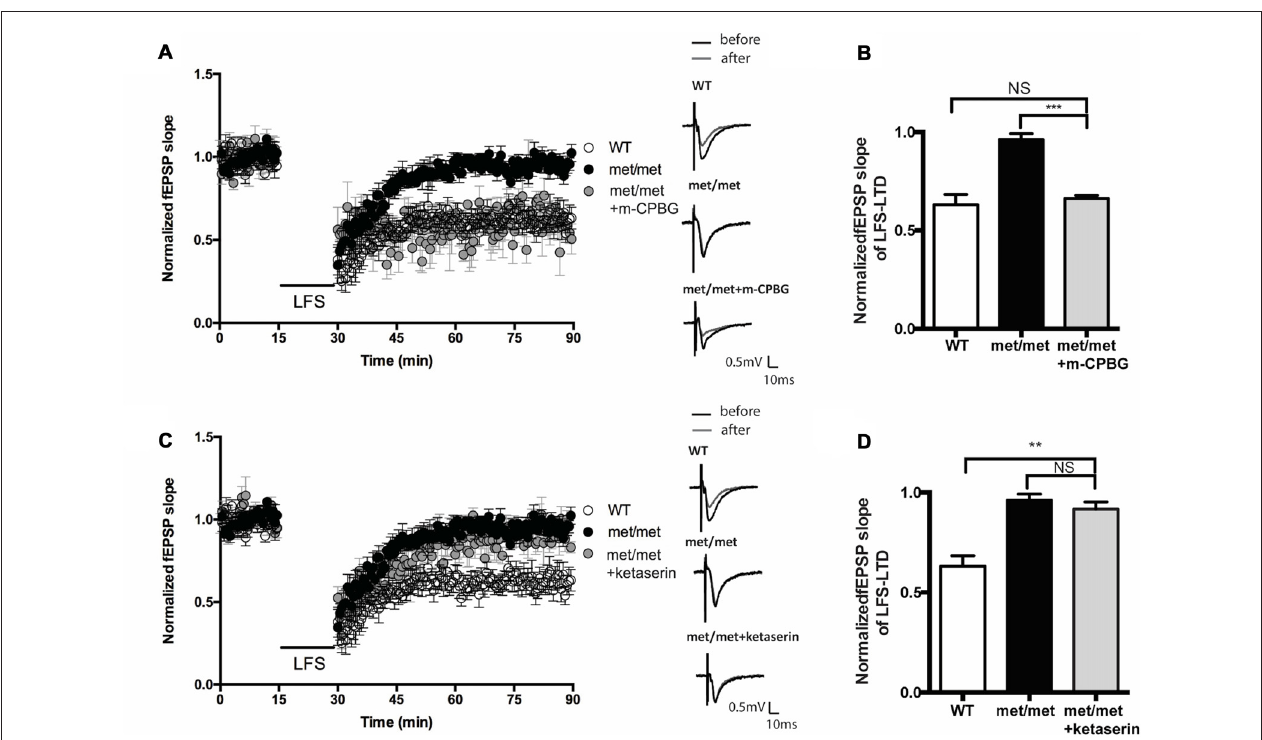
FIGURE 6 | Effect of 5-HT2cR antagonist and 5-HT3aR agonist on LFS-LTD in BDNF Met / Met mice. (A) LFS induced hippocampal LTD. Insert in (A) : typical fEPSP recordings were shown before LFS (black) or 60 min after LTD induction (gray). (B) Summary of the data showed 5-HT3aR agonist m-CPBG (1 µ M) rescued LFS-LTD (WT: N = 7 from 5 mice; BDNF Met / Met : N = 6 from three mice; BDNF Met / Met +m-CPBG: N = 7 from four mice). (C) LFS induced hippocampal LTD. Insert in (C) : typical fEPSP recordings were shown before LFS (black) or 60 min after LTD induction (gray). (D) Summary of the data showed 5-HT2cR antagonist ketanserin (20 µ M) failed to rescue LFS-LTD (WT: N = 7 from four mice; BDNF Met / Met : N = 6 from four mice; BDNF Met / Met + ketanserin: N = 6 from three mice). NS P > 0.05, ∗∗ P < 0.01, ∗∗∗ P < 0.001.